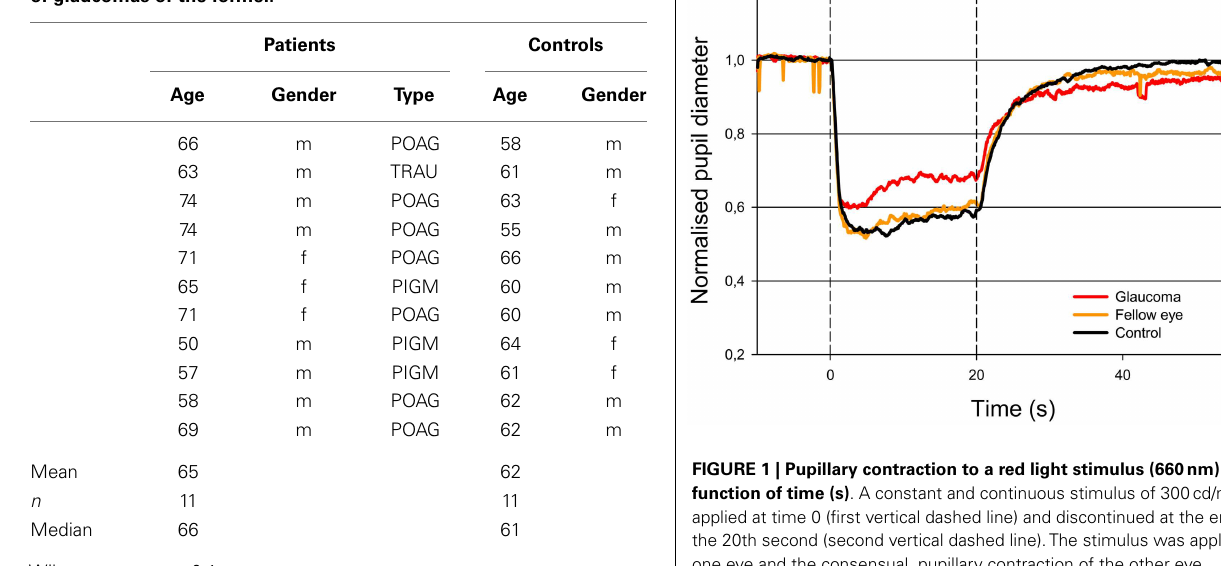
Table 1 |Age and gender of patients and controls together with type of glaucomas of the former.